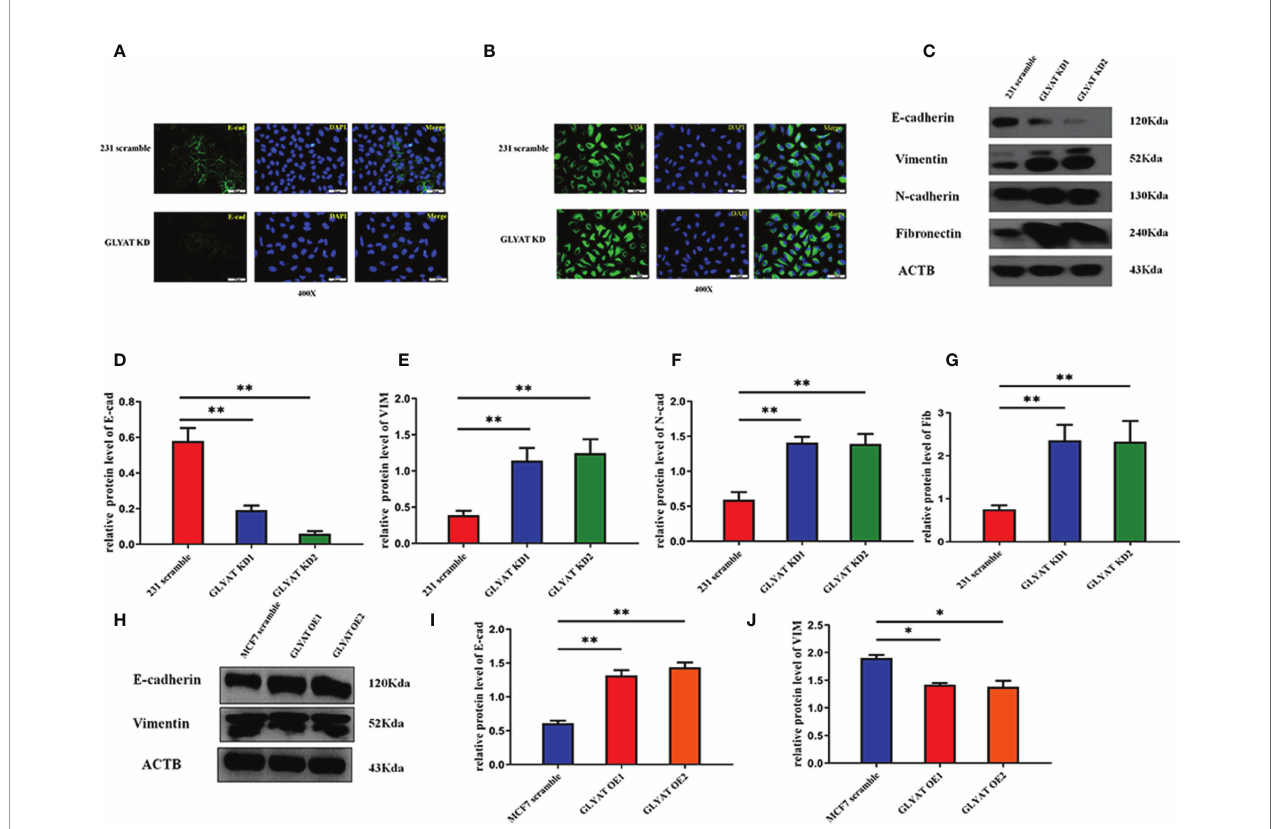
FIGURE 3 | GLYAT suppress EMT phenotype in BC cells. (A, B) Immuno fl uorescence assay showed that E-cadherin expression was decreased and the vimentin expression was increased after the treatment of GLYAT KD. (C – G) Protein levels of E-cadherin was reduced, whereas the levels of Vimentin, N-cadherin, and Fibronectin were increased in MDA-MB-231 cells following GLYAT inhibition. (H – J) Protein levels of E-cadherin was increased whereas the expression of Vimentin was reduced in GLYAT OE MCF-7 cells. * p < 0.05, ** p < 0.01. Scale bars are 25 m